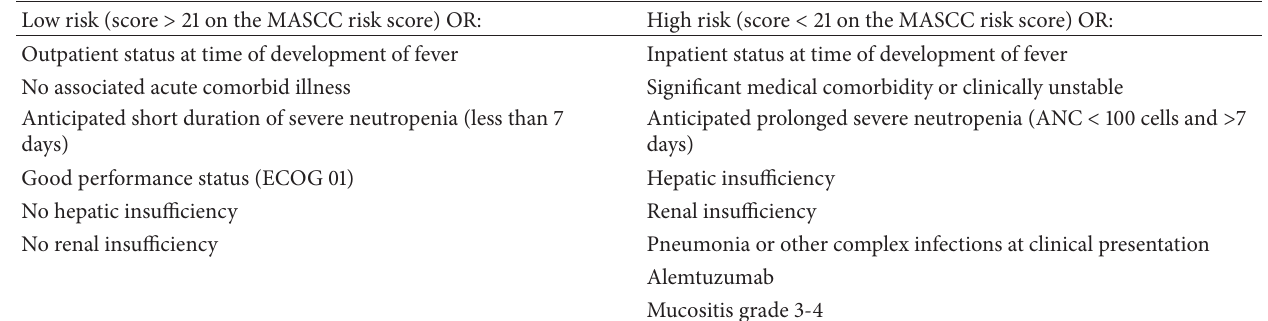
Table 2: Initial risk assessment for febrile neutropenic patients (adapted from NCCN guideline) [7]. Low risk (score > 21 on the MASCC risk score)